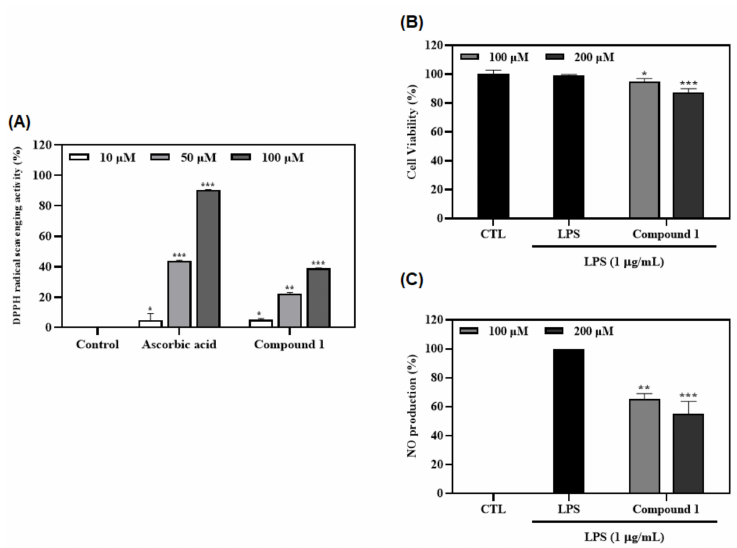
Figure 7. Effects of the compound 1 on radical scavenging activity, cell viability, and NO production. ( A ) The antioxidant effect of compound 1 was evaluated by DPPH radical scavenging assay. The data are expressed as the mean ± SD of three individual experiments. * p < 0.05, ** p < 0.01, and *** p < 0.001 vs. control (blank sample). Ascorbic acid was used as the positive control. ( B , C ) The anti-inflammatory effect of compound 1 was evaluated by cell viability ( B ) and NO production ( C ) assays. Macrophages were treated with compound 1 (100 µ M and 200 µ M) for 1 h and stimulated with LPS (1 µ g/mL) for 20 h. Nitrite concentrations of non-treated and LPS-treated controls were 1.2 ± 0.1 µ M and 7.5 ± 0.4 µ M, respectively. Cell viability ( B ) and NO production ( C ) were conducted using MTT assay and Griess reagent, respectively. The data are expressed as the mean ± SD (n = 3) of three individual experiments. * p < 0.05, ** p < 0.01, and *** p < 0.001, compared with control (blank